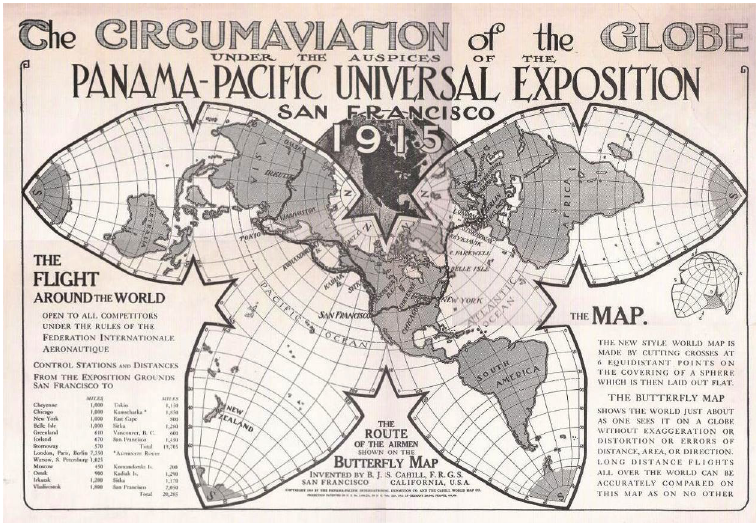
Fig. 13. Cahill’s map awarded in San Francisco in 1915 (source: portal Gene Keyes